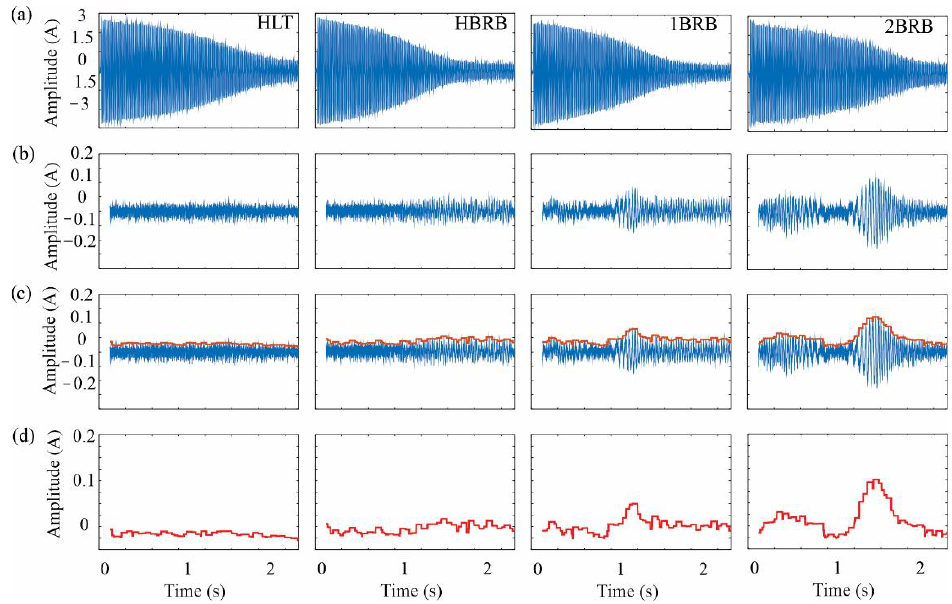
Figure 15. ( a ) Current signal, ( b ) Second extracted component, ( c ) Quantization of the component, ( d ) Upper envelope.